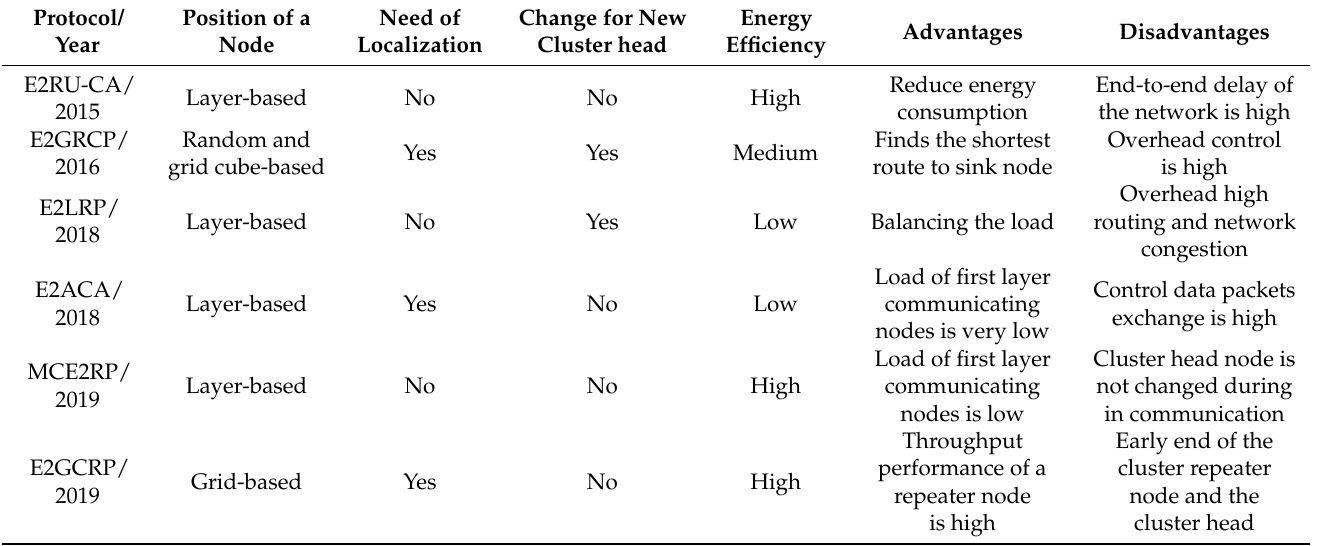
Table 9. A thorough analysis of cluster-based energy-efficient routing protocols